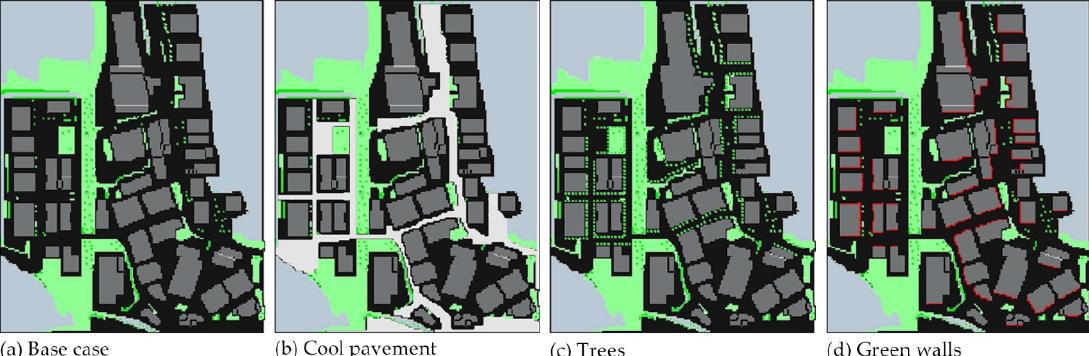
Figure 3. Different configurations of the green strategies applied in the entire industrial district (M1). In the figure ( a ) is the base case, ( b ) is the configuration with cool pavement, ( c ) is the config- uration with trees, ( d ) is the mitigation strategy with green walls. In the case of ( d ), the red lines represent the green façades.